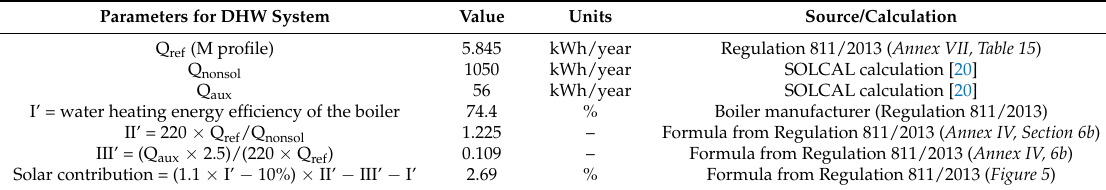
Table 5. Parameters needed for the calculation of the water heating energy efficiency in the case